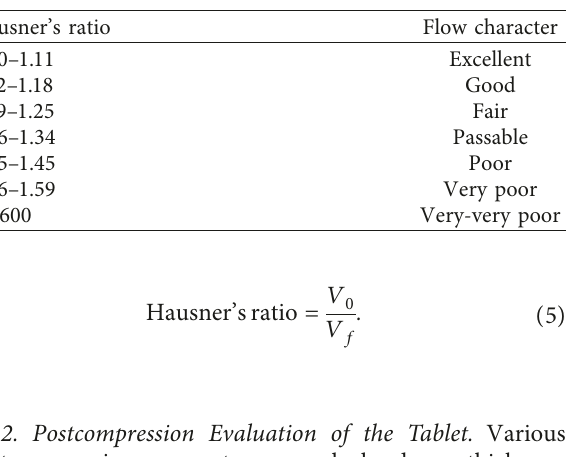
Table 4: Effect of Hausner’s ratio on flow